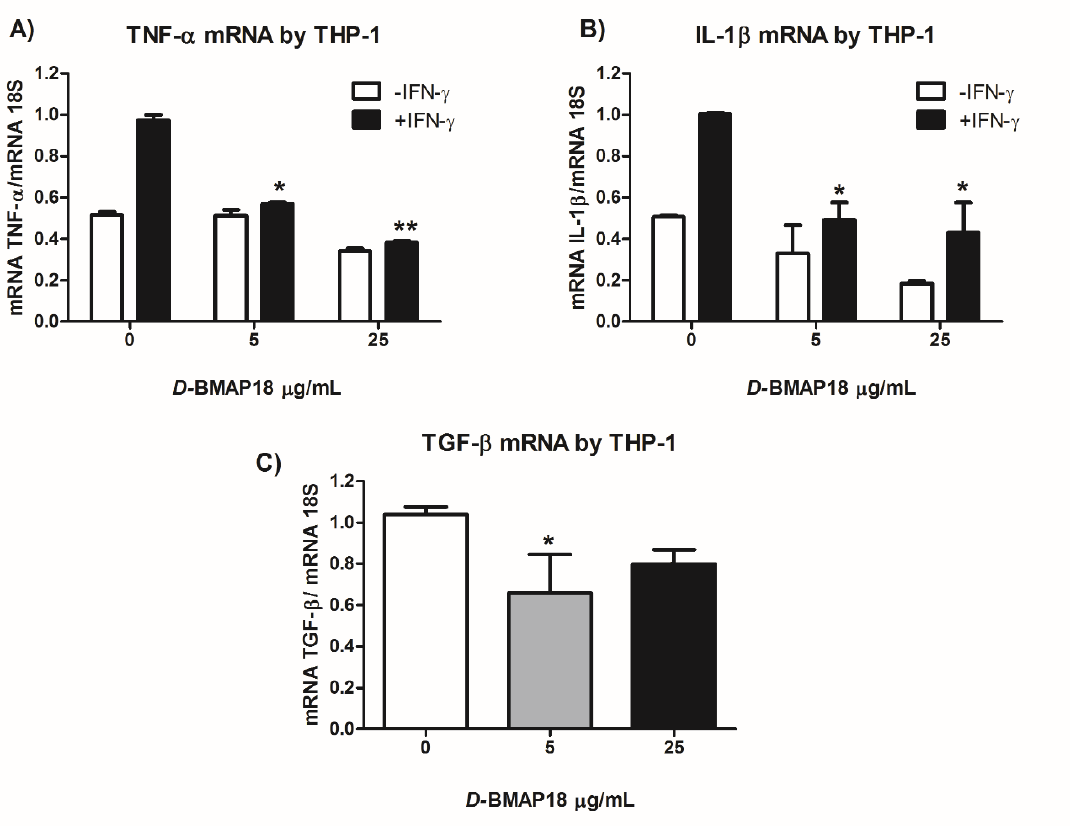
Figure 6. D -BMAP18anti-inflammatoryactivityonTHP-1cells. RT-qPCRanalysisofthepro-inflammatory Figure 6. D -BMAP18 anti-inflammatory activity on THP-1 cells. RT-qPCR analysis of the pro- cytokines ( A ) TNF- α ; ( B ) IL1- β and anti-inflammatory cytokine; ( C ) TGF- β after 24 h treatment with inflammatory cytokines A ) TNF-α; B ) IL1-β and anti-inflammatory cytokine; C ) TGF-  after 24h IFN- γ (5000 U / mL), and / or D-BMP18 at 5 and 25 µ g / mL. The cytokine expression in presence of IFN- γ treatment with IFN-γ (5000 U/mL), and/or D-BMP18 at 5 and 25 μg/mL. The cytokine expression in presence of IFN-γ and D -BMAP18 was expressed as fold increase compared to the IFN-γ alone. The results are the average of two independent experiments in internal duplicates ( n = 4). * = p < 0.05, ** p < 0.01. Student t -test.